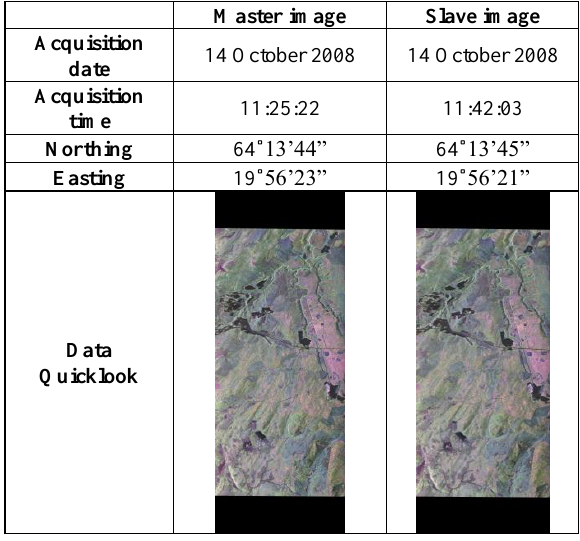
Table 1: Airborne data characteristics